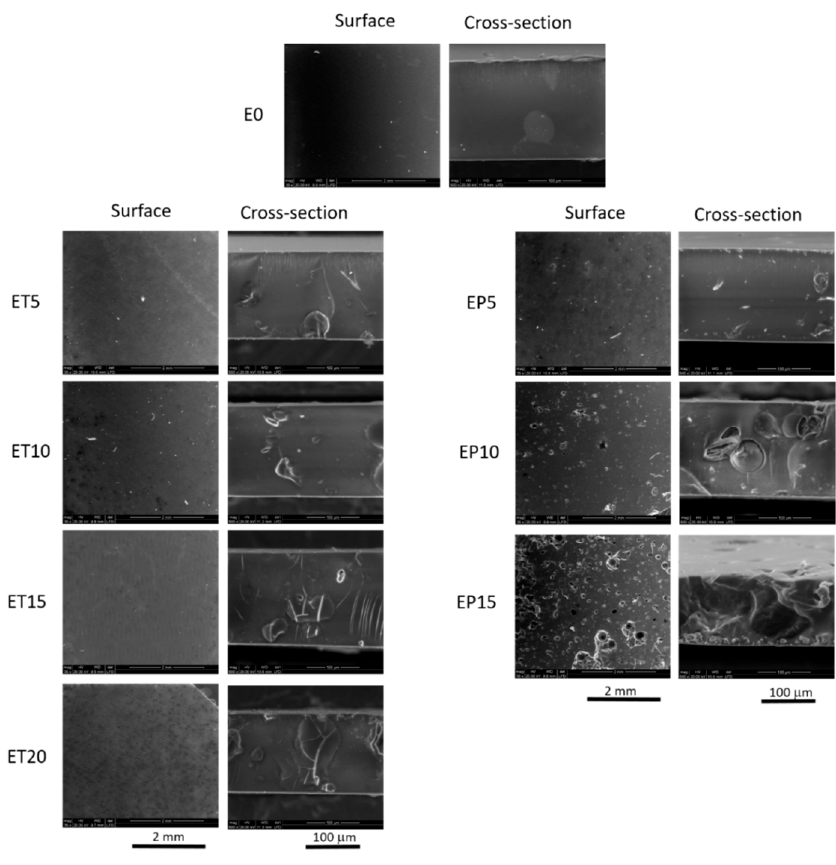
6 of 17 Figure 2. Optical micrographics of ET10 ( A ) and EP10 films ( B ). Figure 3 shows membrane surfaces and cross-sections captured by means of ESEM microscope. E0 membrane possesses dense structure, while in case of the composite films, the presence of the fillers can be easily evidenced in their cross-sections. Furthermore, the ESEM cross-section micrographs show that both TP and TGP particles are well incorporated in the membrane structures and they form a part of compact films. Surfaces of the membranes prepared with tea powder seem to